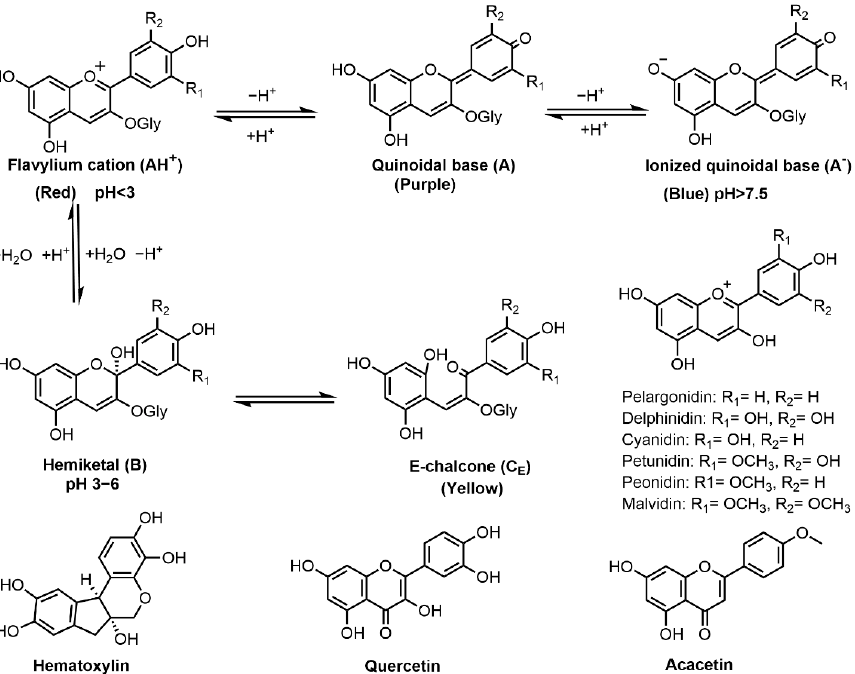
Figure 4. Chemical structures of flavonoids (anthocyanins, hematoxylin, quercetin and acacetin) and the effect of pH on anthocyanin structure and resultant color.